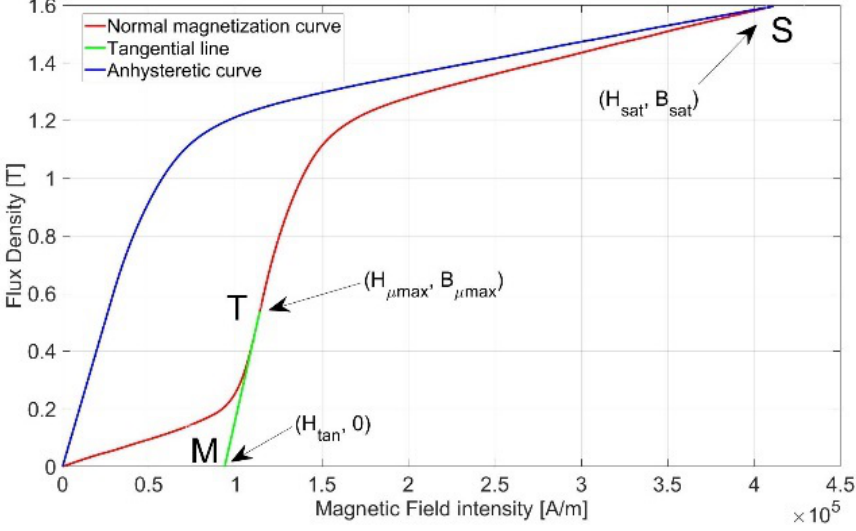
Figure 3. Tangential line and Anhysteretic curve.